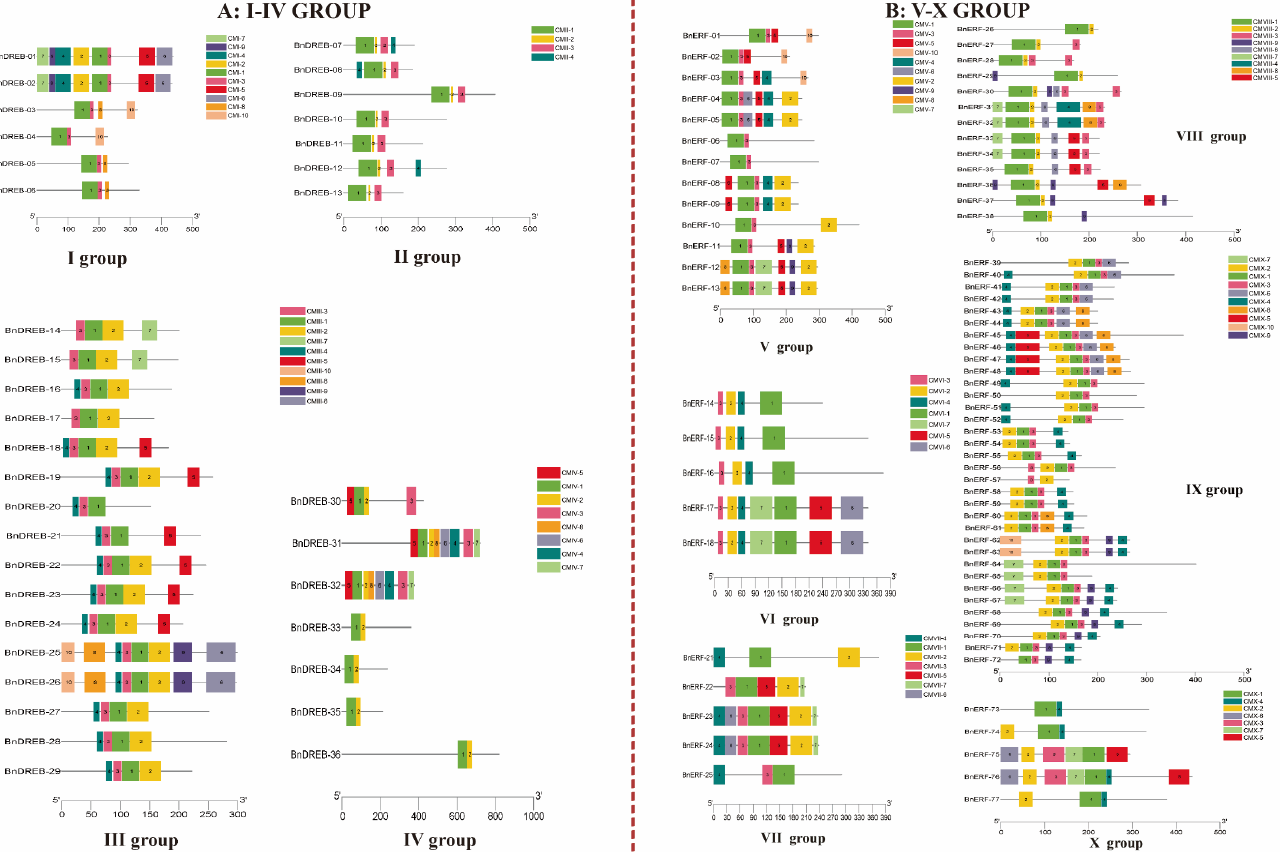
Figure 3. The composition of conserved motifs in ERF subfamily proteins of ramie: ( A ) I–IV group for the BnDREB subfamily; ( B ) V–X group for the BnERF subfamily.